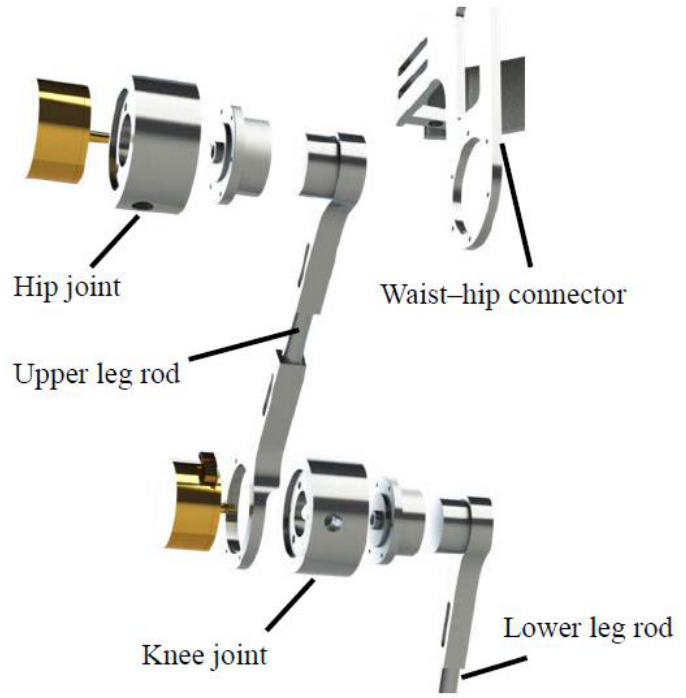
Figure 5. Leg rod and motor plate design of LLRE-II.